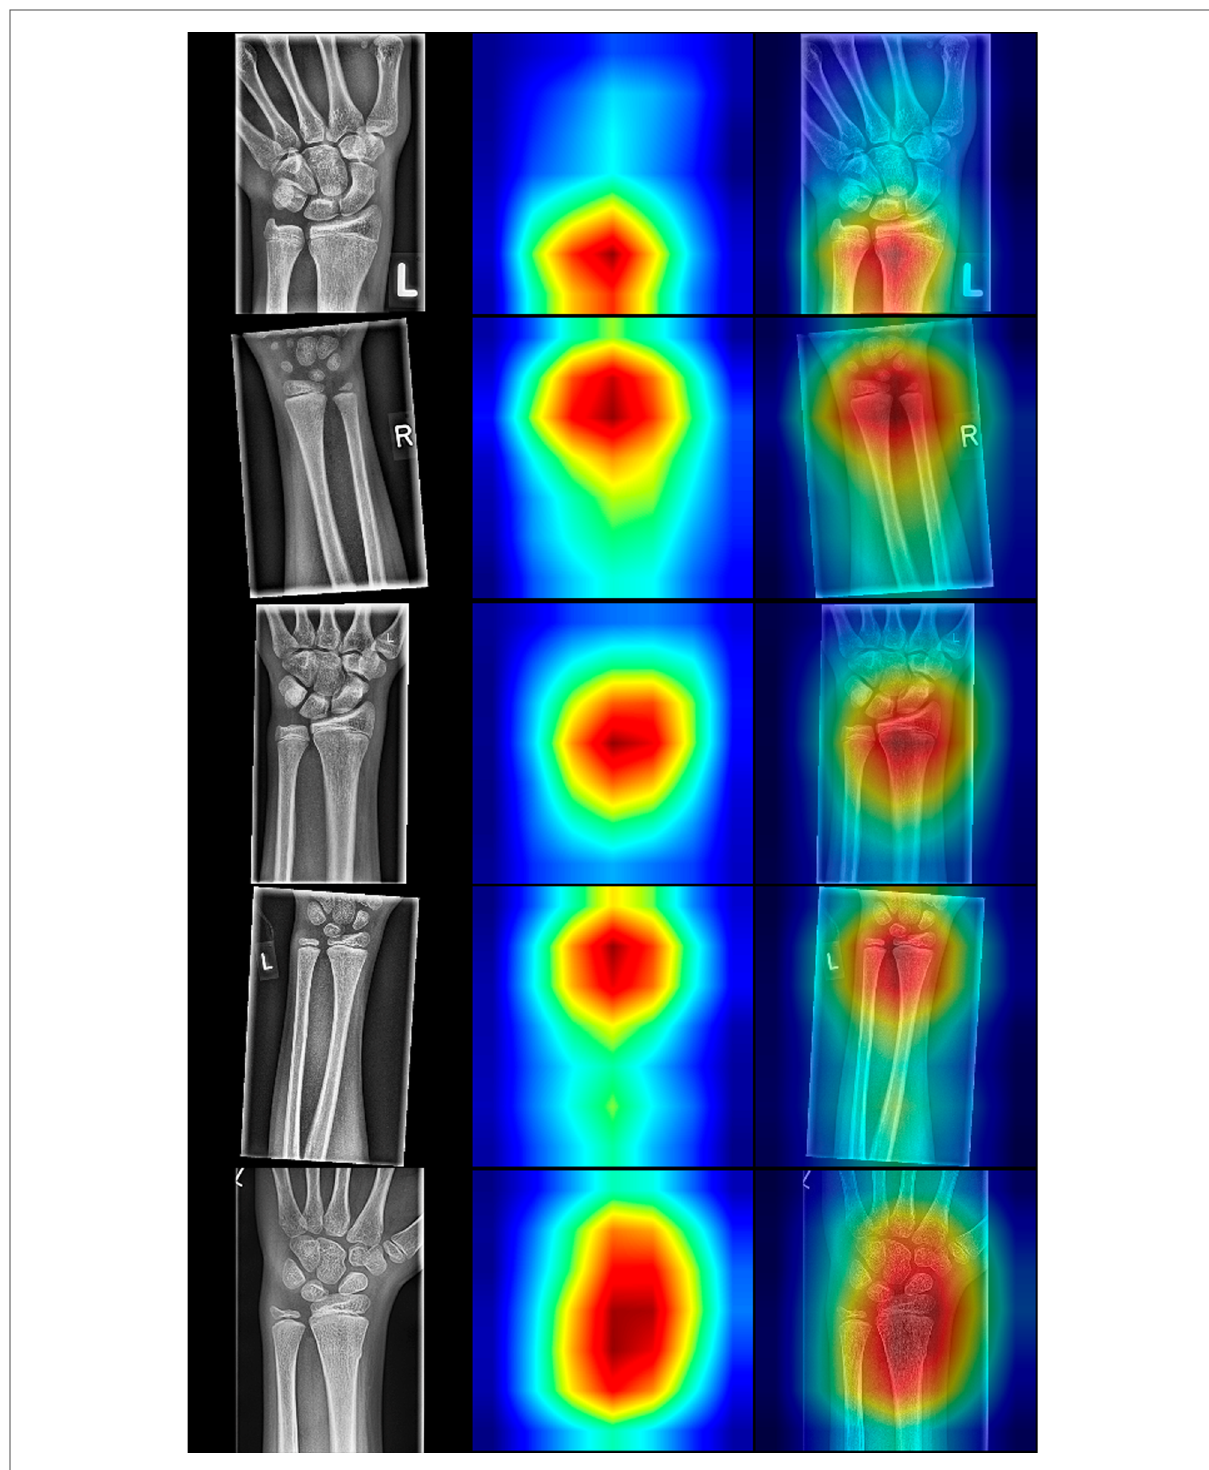
FIGURE 7 Random selection of radiographs positive for fracture with resNet-152 class activation maps (CAMs). The left column displays the source images, the middle column illustrates CAMs, and the right depicts fusions of source and sample images. Note that the classes are activated in the distal forearm region, even though the fi elds of view differ in the presented